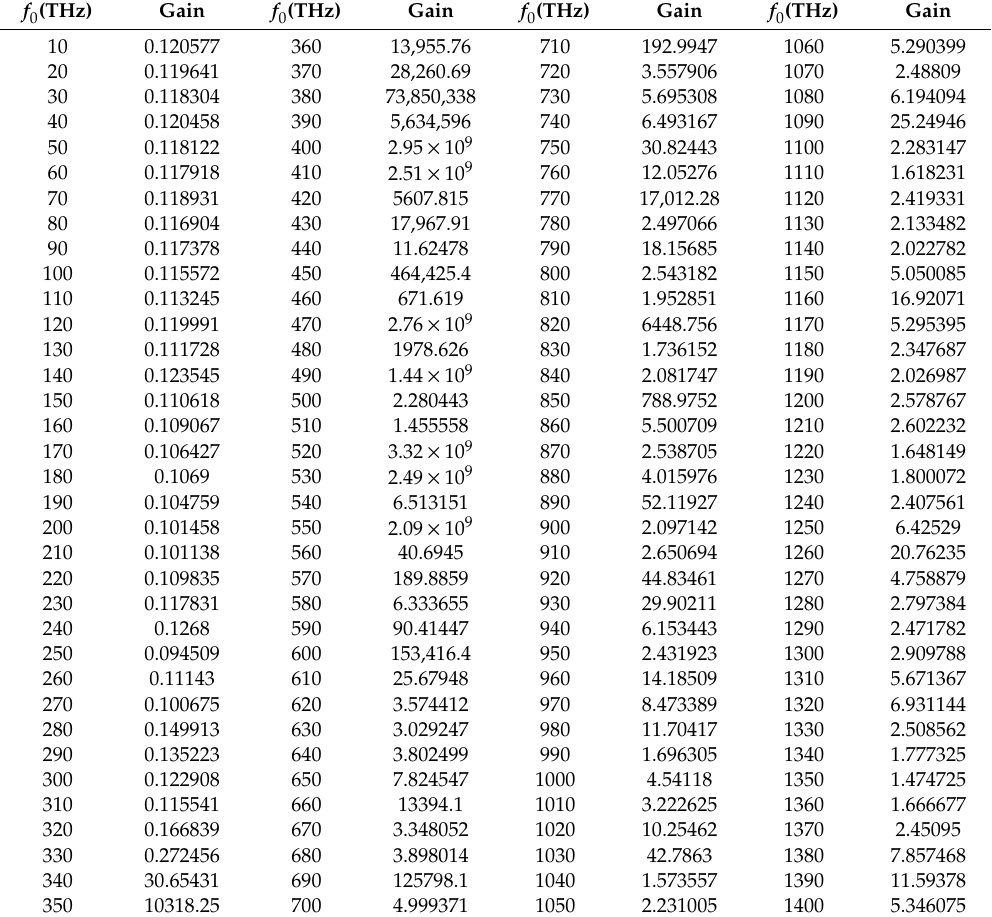
Table 2. Maximum stimulus wave amplitude (gain factor) inside the cavity at x = 5.73 μ m for {0 < t < 30ps, 𝛾 = 1 × 10 (cid:2877) Hz}, versus 𝑓 (cid:2868) . Optimum values are indicated in bold.